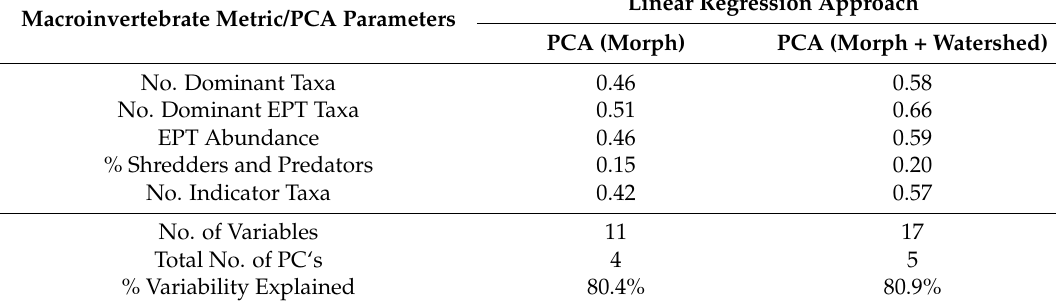
Table 5. Coefficients of determination resulting from linear regression of five macroinvertebrate metrics compared to four PCs resulting from site selection and morphology design variables (11 variables) and five PCs resulting from the morphology variables combined with six watershed factors. Total variance explained by the PCs is also reported. PCA refers to principal component analysis. EPT refers to Ephemeroptera (mayflies), Plecoptera (stoneflies), and Trichoptera